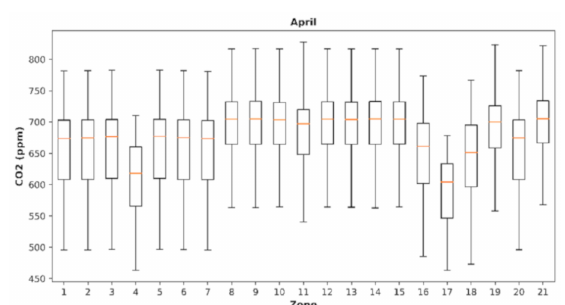
Figure A6. CO 2 concentrations in January.